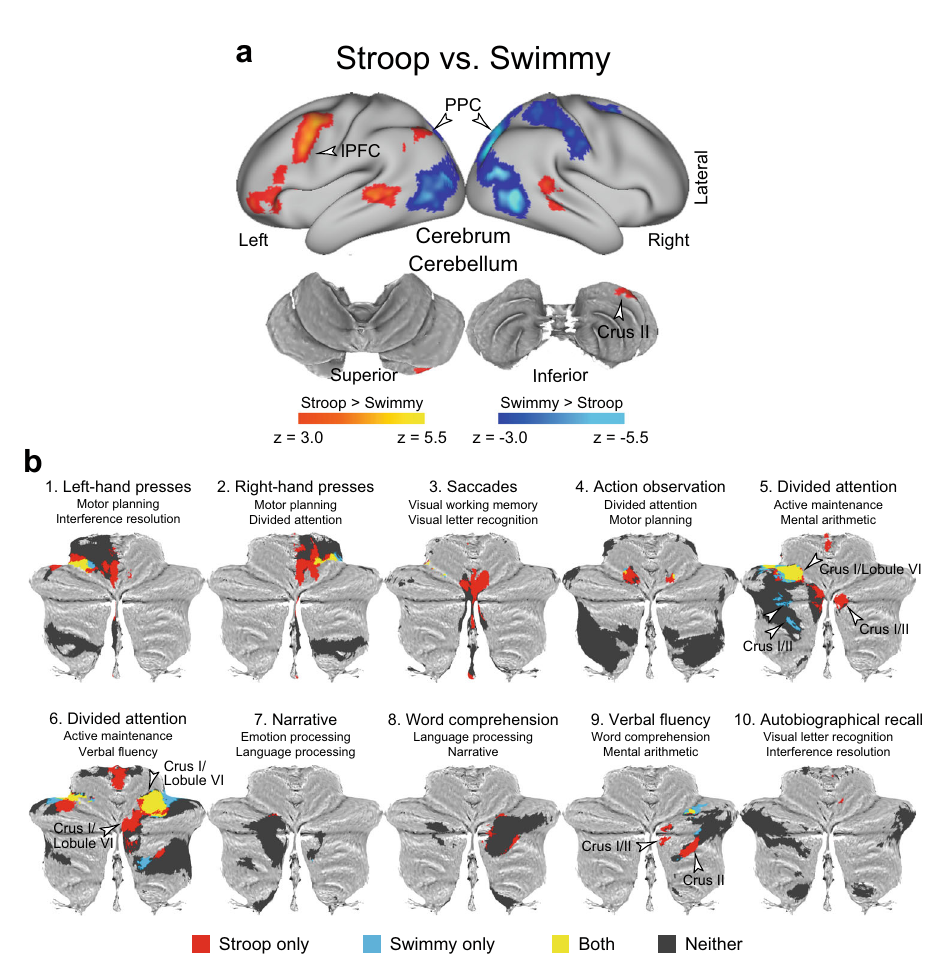
Fig. 6 | Direct comparison of the Stroop and Swimmy tasks and functional characterizationsofthe cerebellum.a TheStroop effect predominantly involves the left lPFC and right cerebellum. Statistical maps showing a differential inter- ferenceeffect (incongruent vs.congruent) betweenthe Stroop and Swimmy tasks. HotandcoolcolorsindicateagreaterinterferenceeffectintheStroopandSwimmy tasks, respectively. Formatsare similarto those in Fig. 3a. b The current results for thecontrastoftheincongruentvs.congruenttrialsintheStroopandSwimmytasks